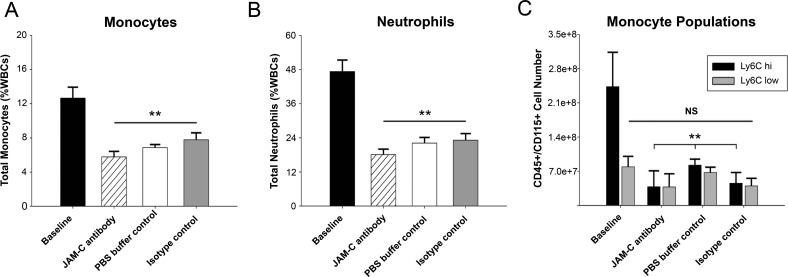
Flow cytometry data from blood monocytes.WBCs were counted by a hemocytometer after red blood cell lysis and stained with leukocyte markers from donor mice (Baseline) and recipient mice groups (JAM-C antibody, PBS buffer-control or an isotype control). (A) Total monocytes were gated for CD45+/CD115hi and expressed as % of total WBCs. (B) Total neutrophils were defined as CD45+/CD115lo/Ly6Chi and expressed as % of WBCs. Data are presented as the mean ±SEM (N = 6). (C) Monocytes were analyzed for Ly6C expression to differentiate Ly6Chi and Ly6Clo populations. NS = not significant. P values marked ** were calculated compared to baseline measurements. Both § and §§ = p<0.01 compared to PBS buffer-control and isotype control recipients.